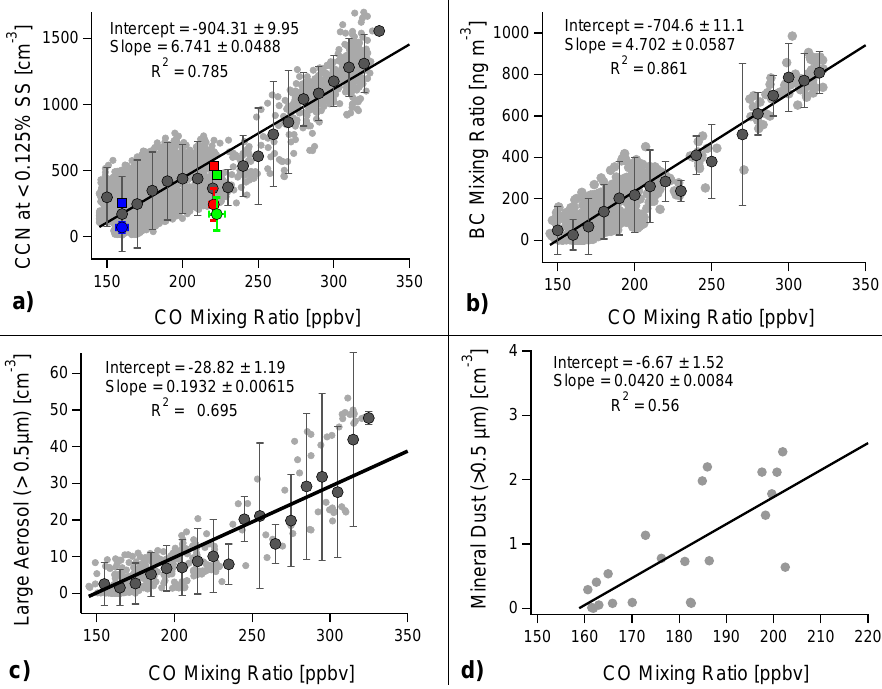
Fig. 2. (a) Cloud Condensation Nuclei (CCN), (b) black carbon (BC), (c) ) large aerosol, and (d) mineral dust concentrations as a function of carbon monoxide (CO) mixing ratios in clear air during the 19 April 2008 flight. Average (circles) and maximum (squares) measured cloud droplet concentrations for the 3 cases introduced in Fig. 1 are also plotted in Fig. 2a. In polluted conditions (i.e. higher CO), both more CCN and more IN are